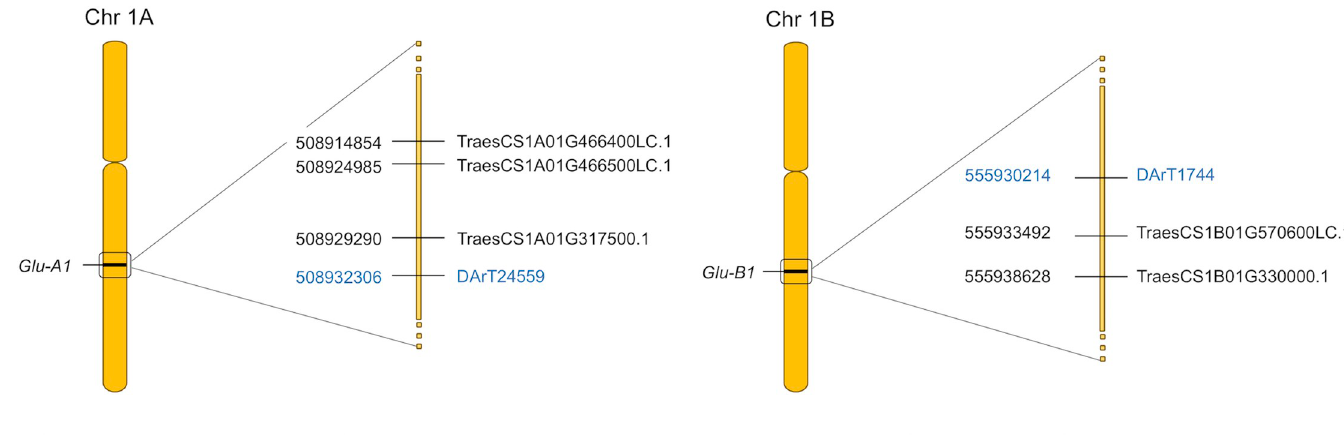
Fig 5. Candidate genes and related markers located on chromosomes 1A and